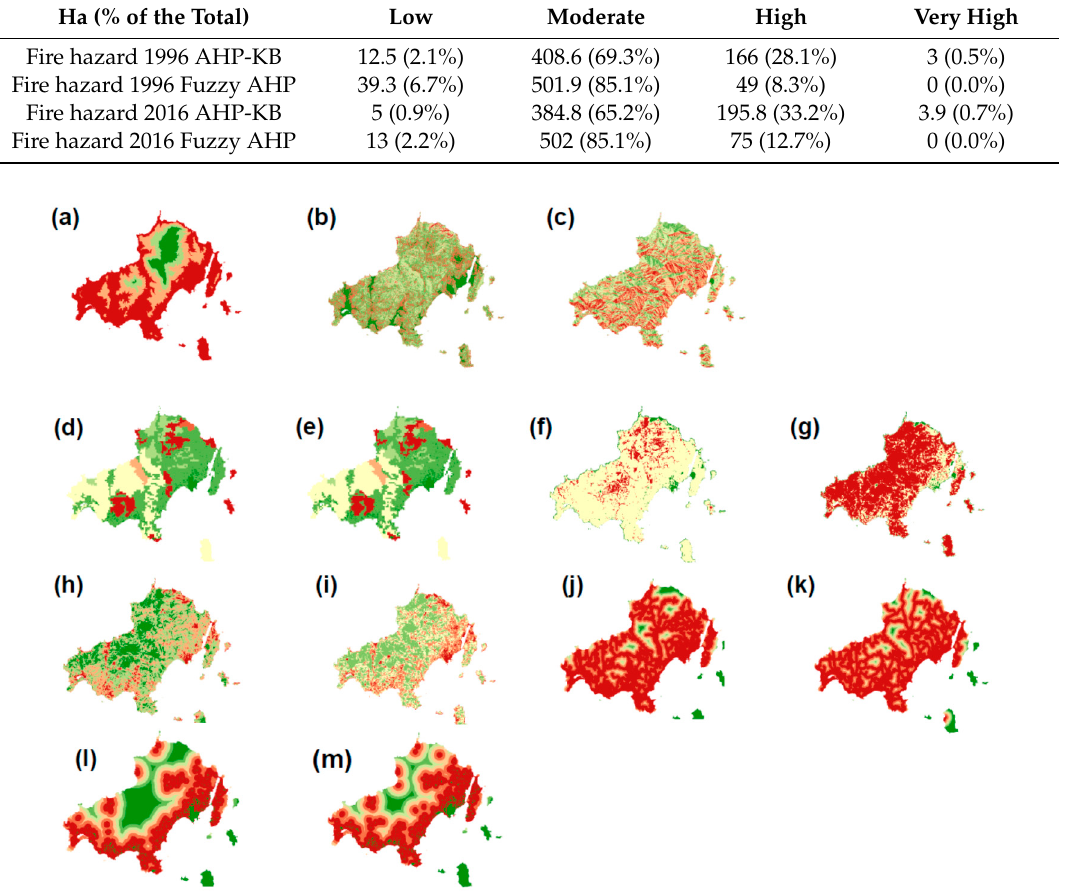
Figure A1. Knowledge-based individual fire hazard maps for 1996 and 2016 (for all involved factors) ( e ) Refined land cover 2016, ( f ) NDVI 1996, ( g ) NDVI 2016, ( h ) NDMI 1996, ( i ) NDMI 2016, ( j ) proximity to road network 1996, ( k ) proximity to road network 2016, ( l ) proximity to human residences 1996, and ( m ) proximity to human residences